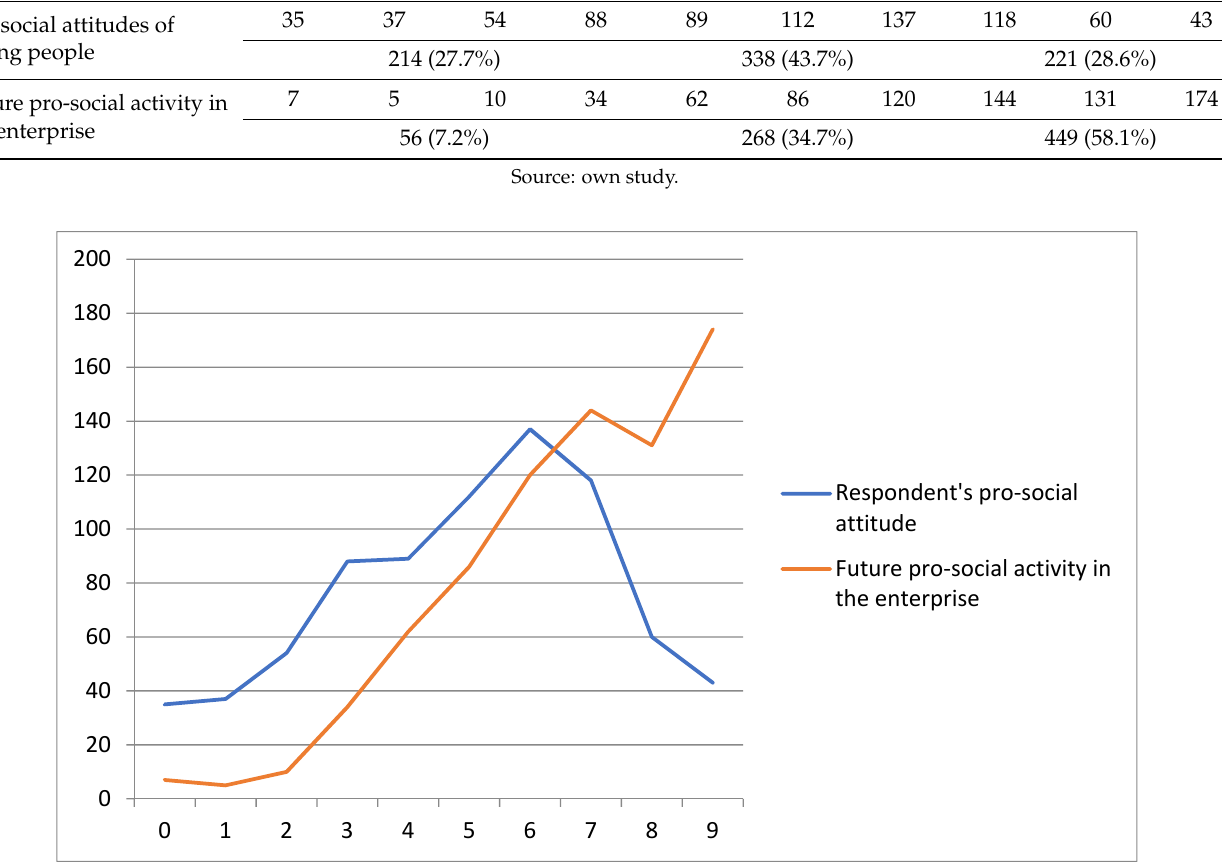
Figure 3. The structure of the pro-social orientation of the younger generation. Source: own study (based on Table 3).